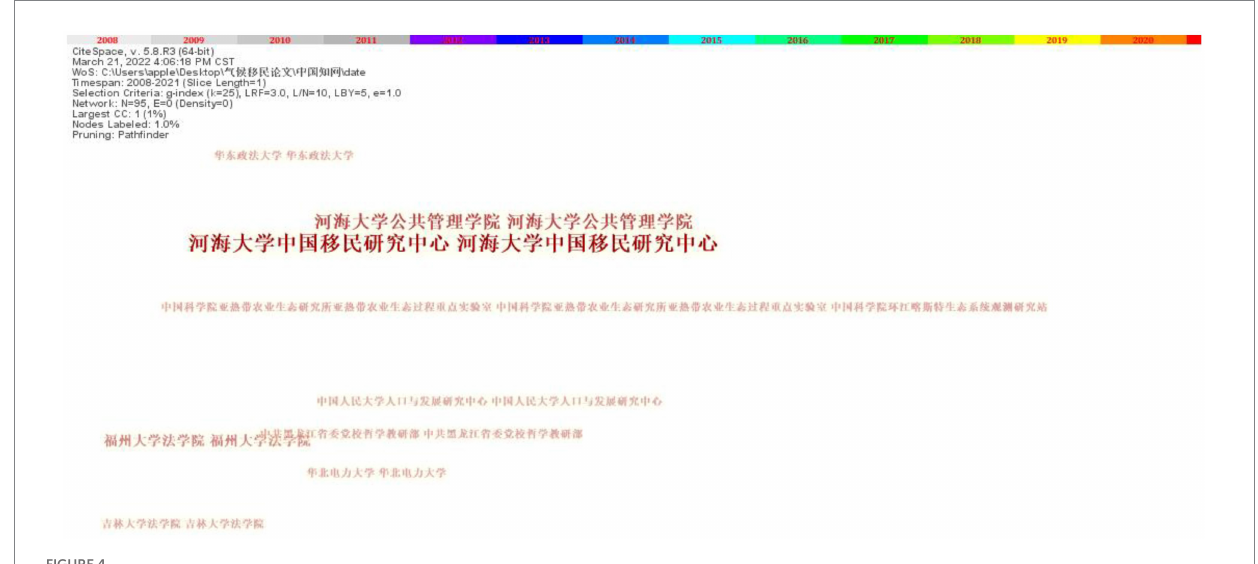
FIGURE 4 Map of the cooperation network of research institutions